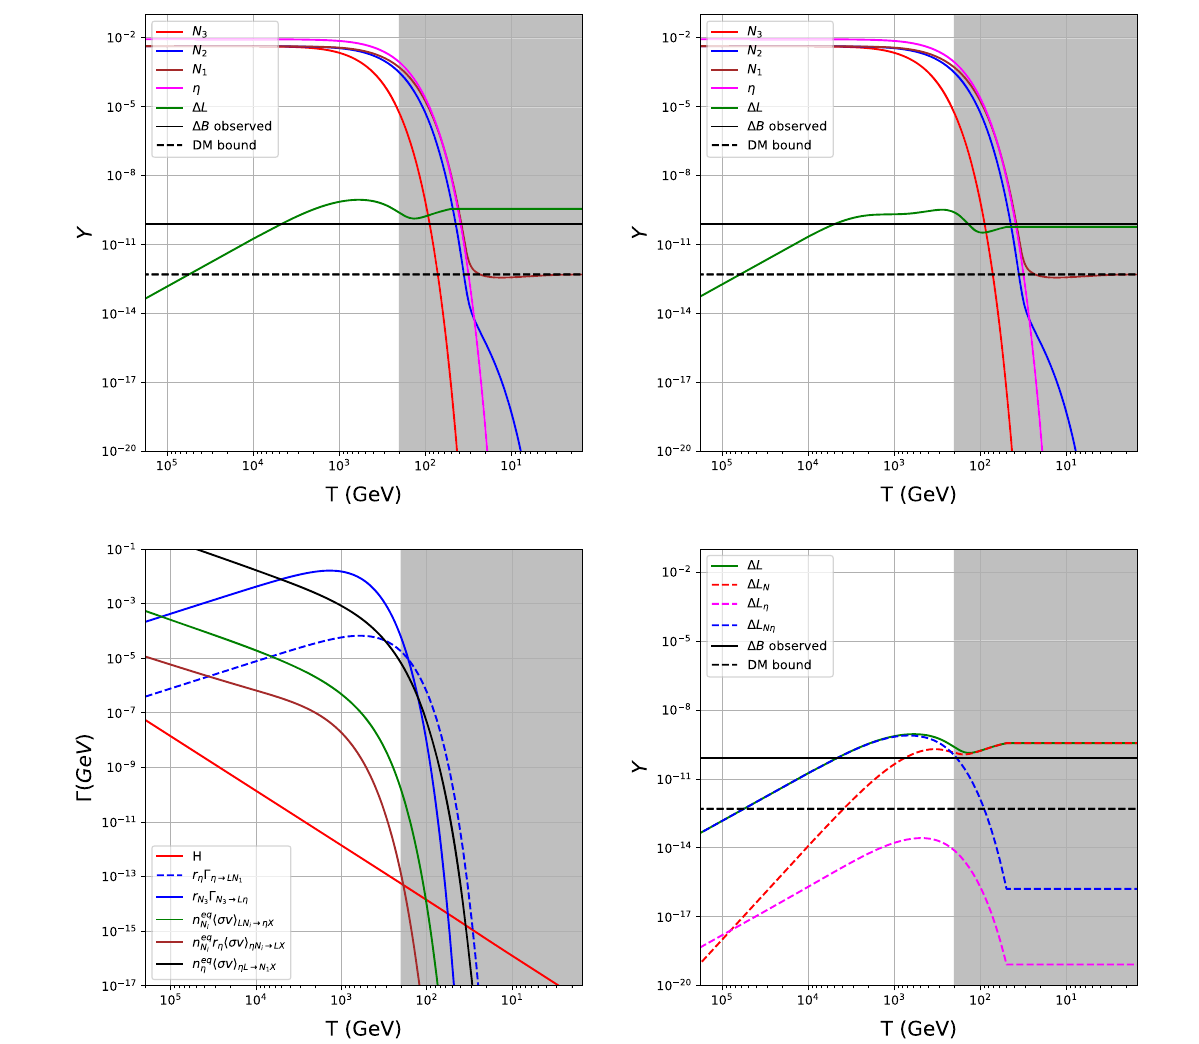
(co)annihilation contributions of each channel to the asymmetry. The solid (dashed) black line corresponds to the baryon asymmetry (DM abundance) observed at present epoch ( T ∼ 0). Shaded regions